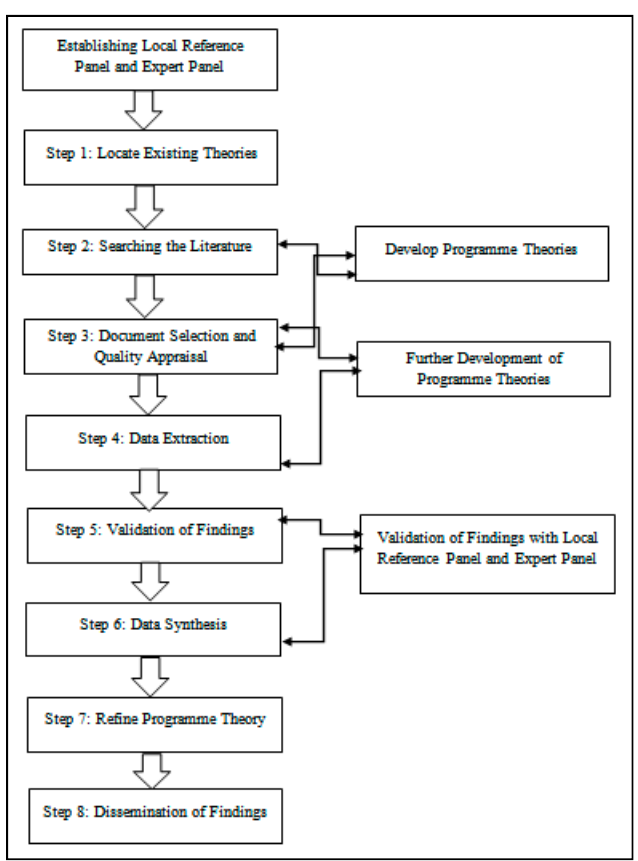
Figure 1. Review design.